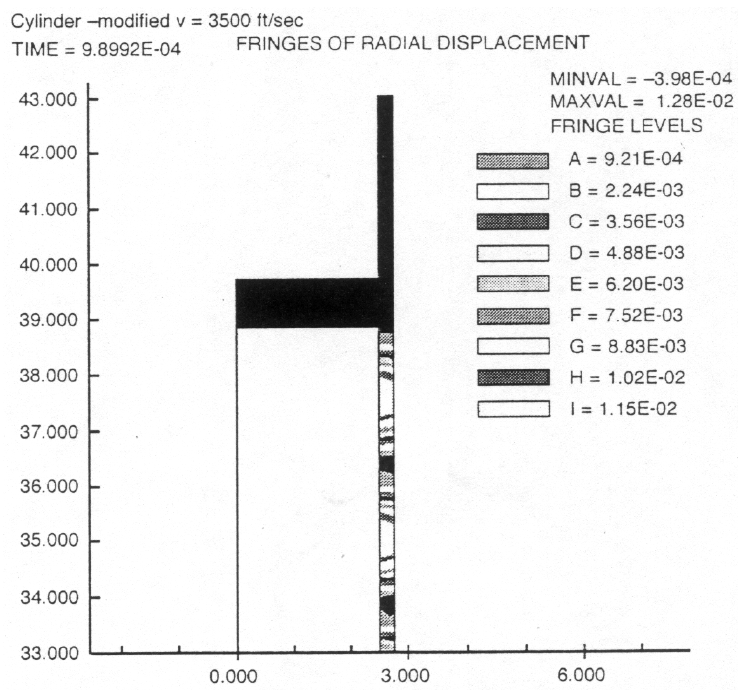
Fig. 4. Radial displacement in the vicinity of projectile